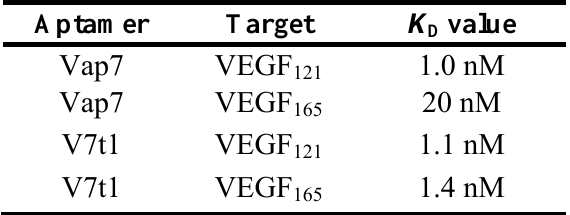
Figure 5. (a) CD spectrum of V7t1. (b) Presumed structure of V7t1. Aptamer V7t1